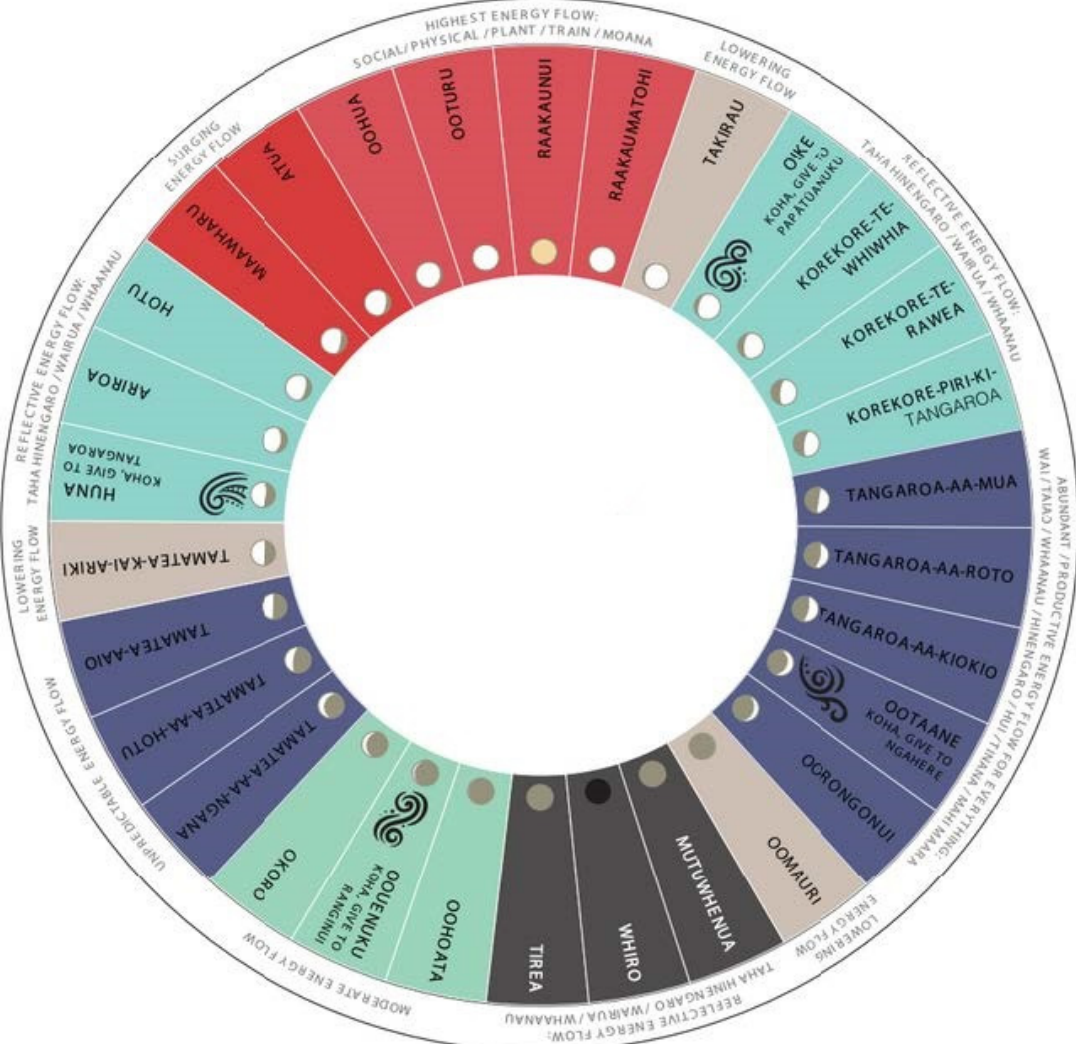
Figure 1. A contemporary visual representation of one maramataka from the Manukau region. In this example, 30 days are outlined with their respective names and correlating lunar phase, while the outer ring outlines the differing levels of activity or ‘energy’ relating to that period. Designed and developed by Ayla Hoeta.